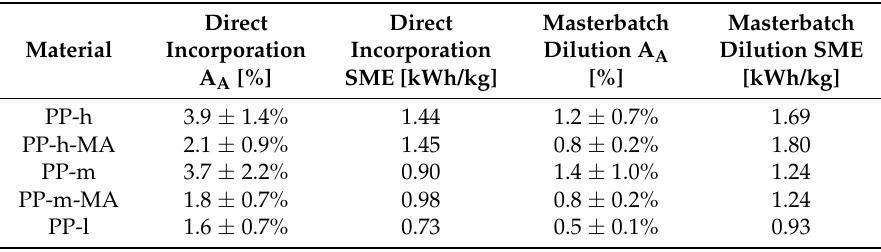
Table 2. State of dispersion (agglomerate area ratio A A ) for composites with 2 wt % MWCNT prepared using direct incorporation and masterbatch dilution (masterbatch with 7.5 wt %, diluted to 2 wt %); preparation at 210 ◦ C, 5 min, 250